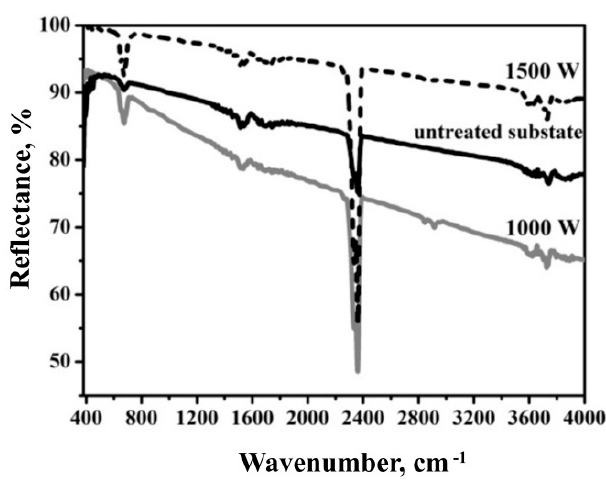
Figure 2. FTIR spectra of DLC films deposited on untreated and electron beam treated substrates.